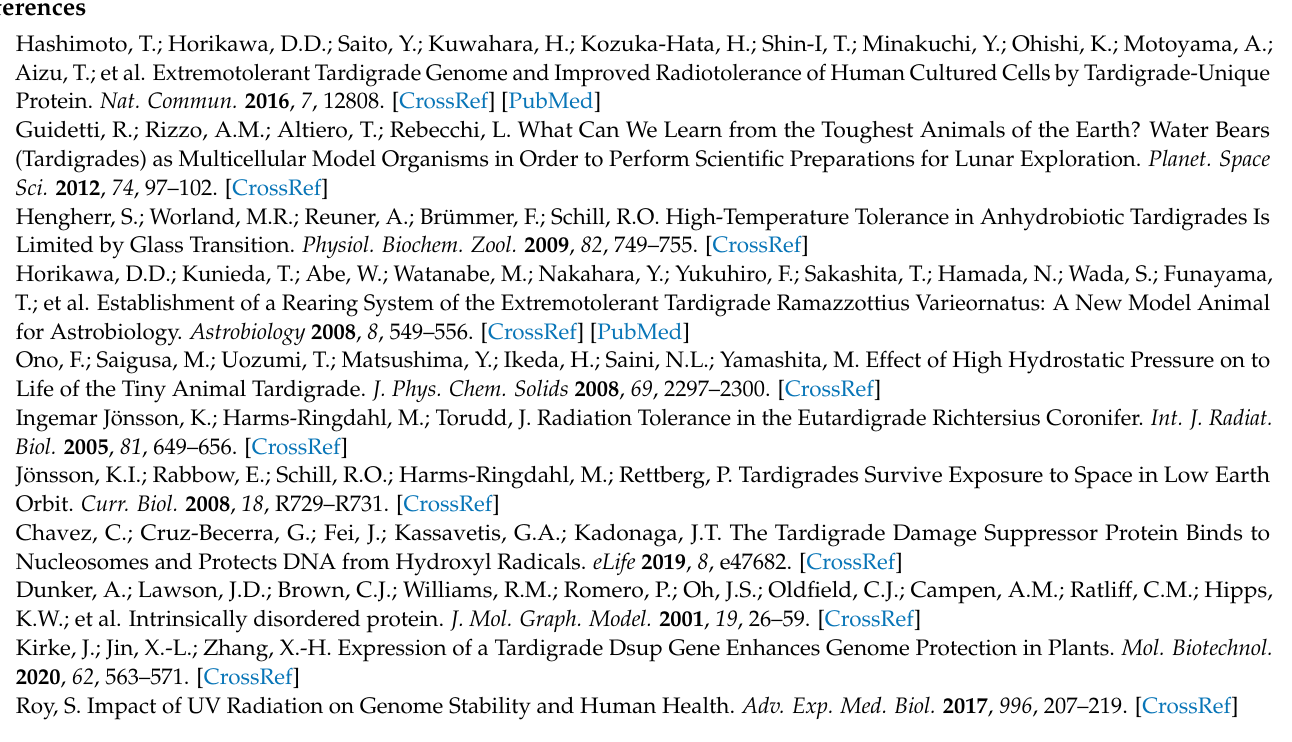
Figure S3: Relative expression of selected gene after UV-C treatment. Table S1: Primer sequences, Table S2: Gene ontology and gene